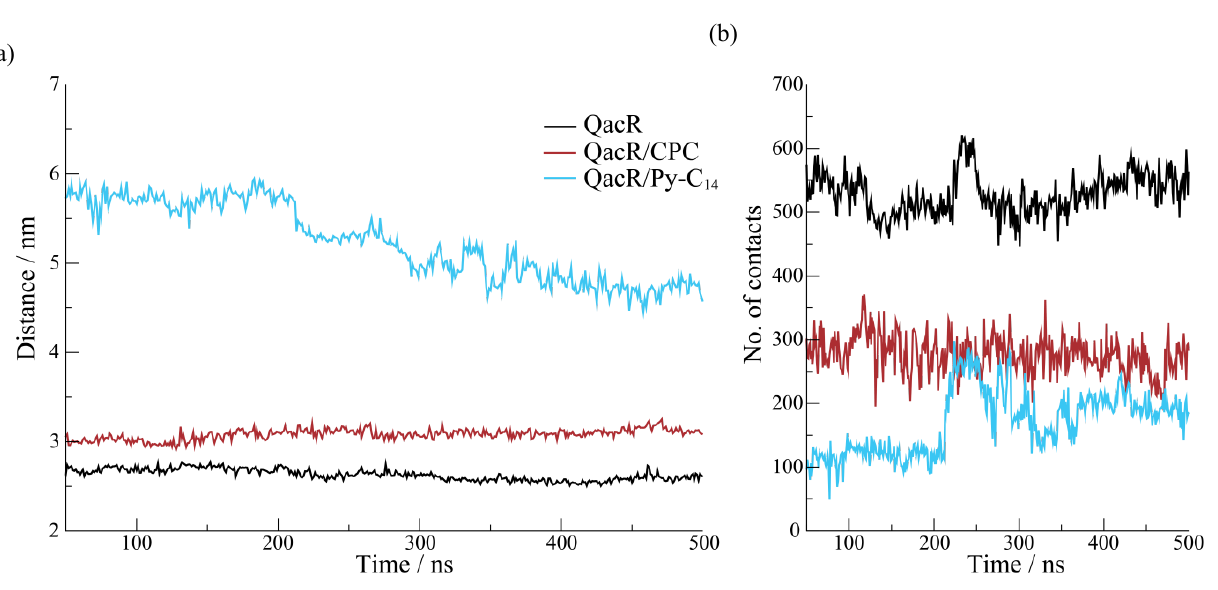
Figure 5. Time evolution of the distance between the centers of mass ( a ) and the number of contacts between the two monomers of the QacR protein ( b ), with the contact threshold set at 0.6 nm.